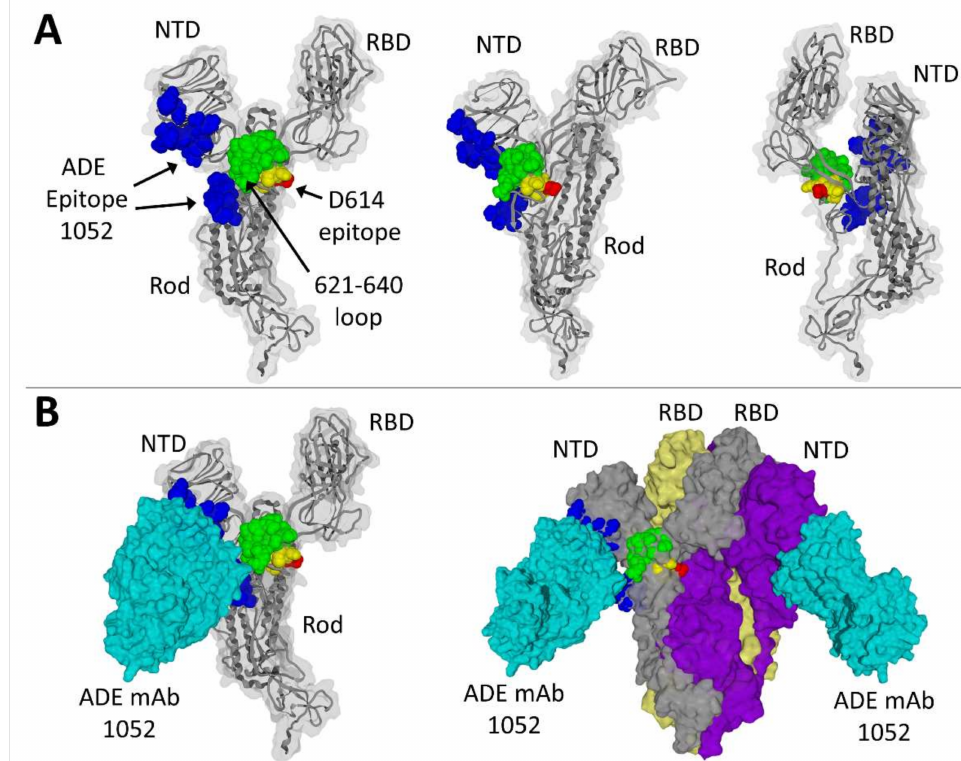
Figure 1. Localization of ADE epitopes on the spike protein. ( A ) Three distinct views of the SARS- CoV-2 spike protein (Wuhan strain). The discontinuous ADE epitope recognized by the 1052 antibody (ADE mAb) is colored in blue. The common coronavirus ADE epitope (D614 epitope) is colored in yellow, with amino acid residue D614 in red. The 621-640 loop that is missing in PDB: 7LAB is in green. ( B ) ADE antibody 1052 (in cyan) bound to the monomeric spike (left panel) or to the trimeric spike protein (right panel). The N-terminal domain (NTD) and receptor-binding domain (RBD) are indicated in all